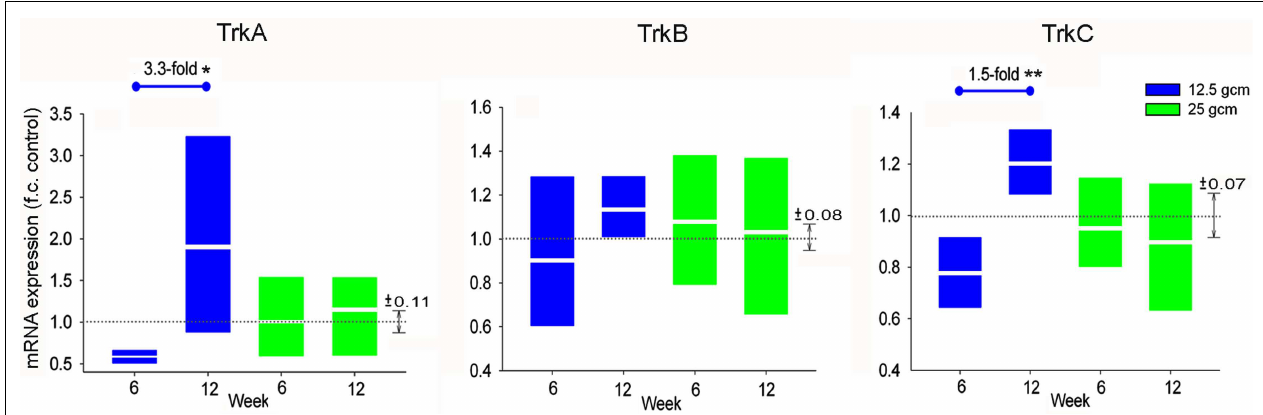
FIGURE 4 | mRNA expression ofTrk receptors is altered in L4/5 spinal cord at 6 and 12weeks after receiving either 12.5gcm (blue) or 25gcm (green) NYU contusion injury to spinal cord at vertebral levelT9. Fold-change (fc) is reported as change of 12week relative to 6week time